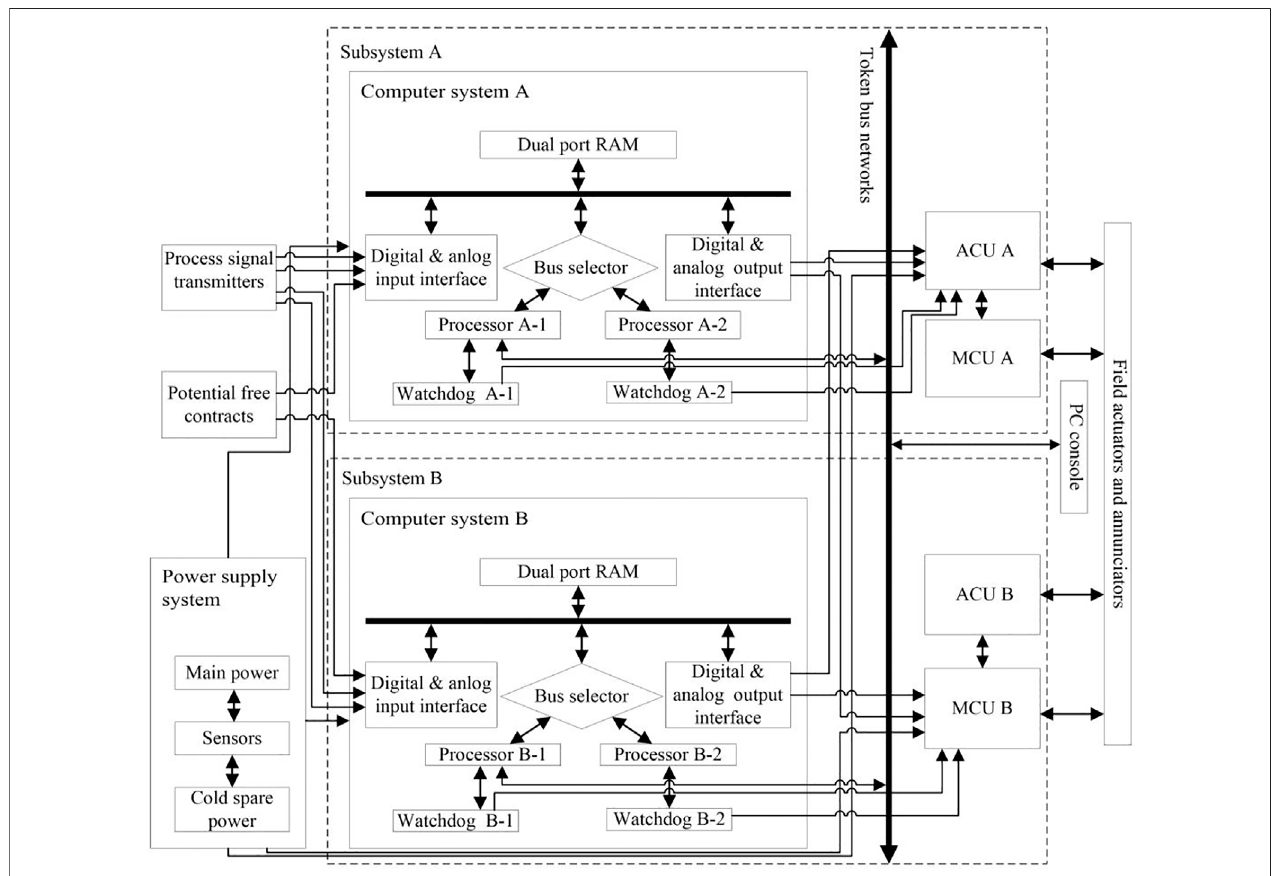
FIGURE 1 | Structure of the